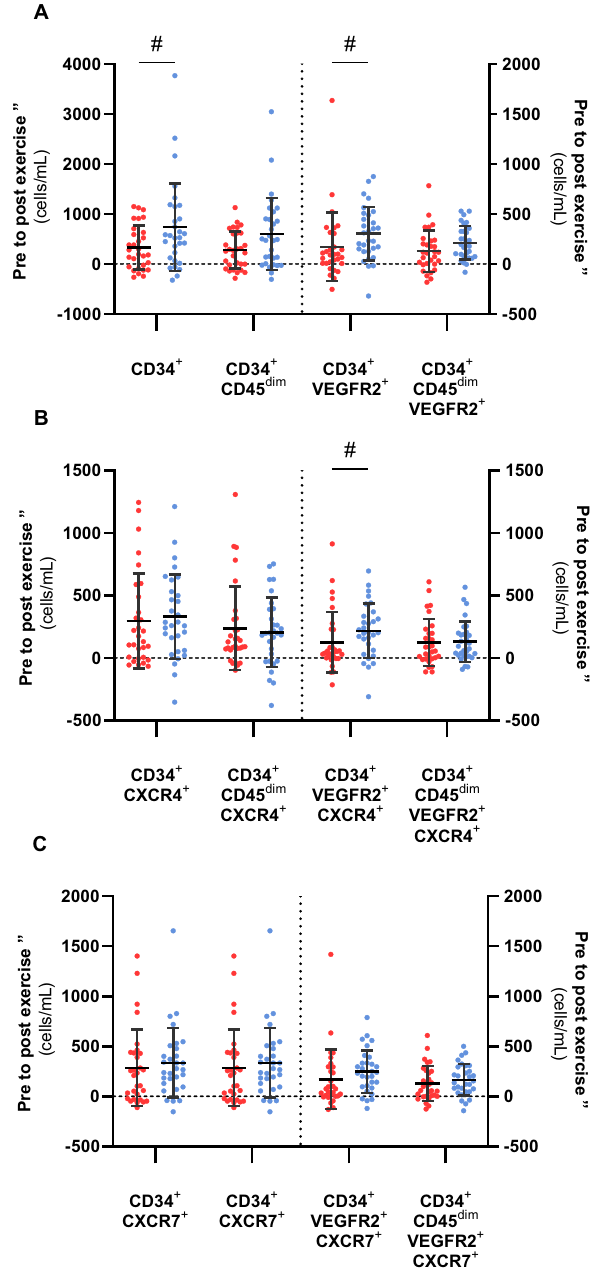
Figure 4. Pre to post exercise delta change (∆ cells, cells/mL) of HPCs and EPCs ( A ), HPCs and EPCs expressing CXCR4 + ( B ), HPCs and EPCs expressing CXCR7 + ( C ) in participants with type 1 diabetes (red circle) and non-diabetes controls (blue circle) in response to a single bout of moderate-intensity exercise. #—signifies significant difference between the type 1 diabetes and non-diabetes groups. Data shown are mean ±